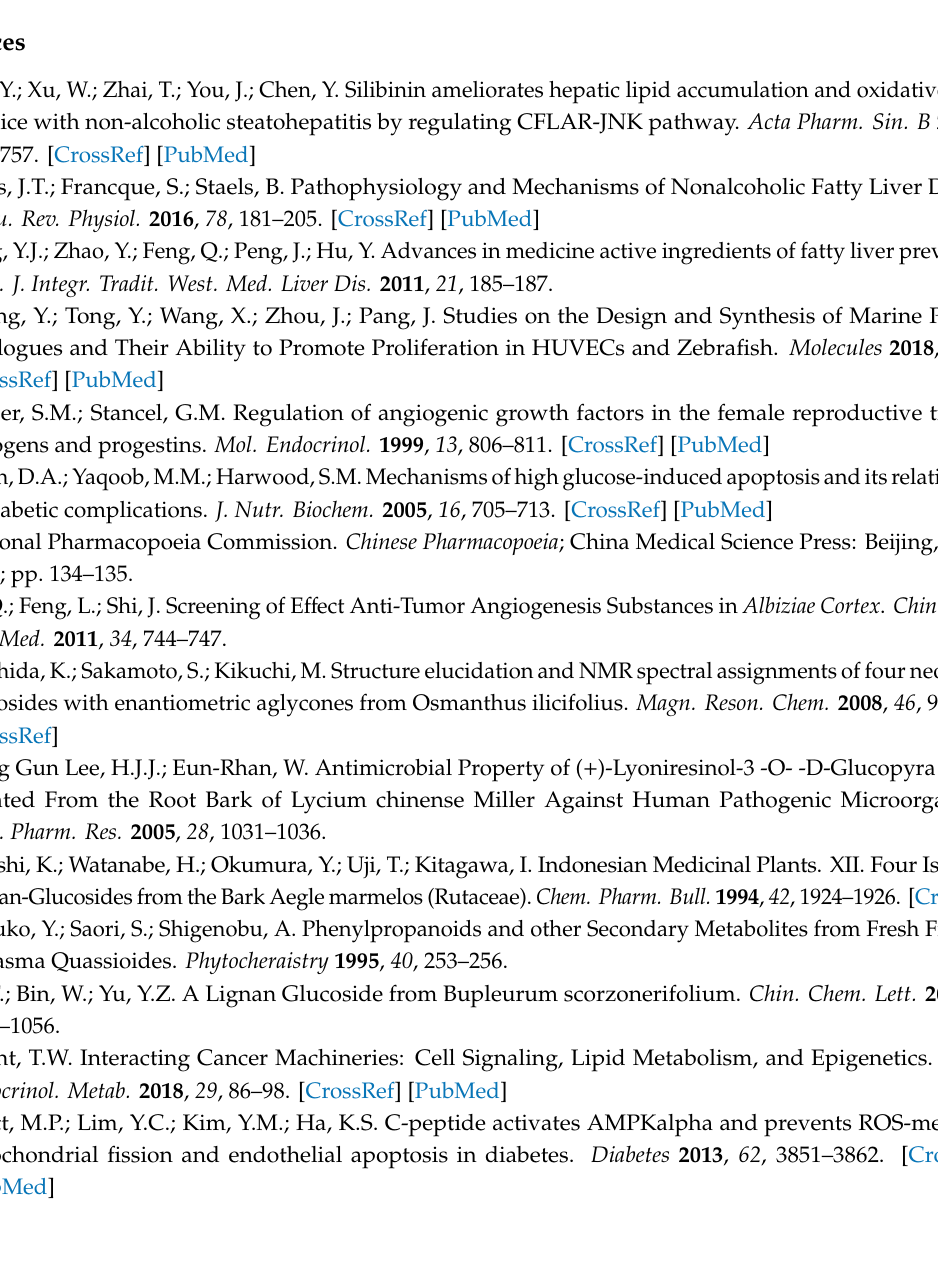
H- 13 C-NMR spectrum of Compound 1. Figure S3: ESI-MS spectrum of Compound 2. Figure S4: 1 H- 13 C-NMR spectrum of Compound 2. Figure S5: ESI-MS spectrum of Compound 3. Figure S6: 1 H- 13 C-NMR spectrum of Compound 3. Figure S7: ESI-MS spectrum of compound 4. Figure S8: 1 H- 13 C-NMR spectrum of compound 4. Figure S9: ESI-MS spectrum of compound 5. Figure S10: 1 H- 13 C-NMR spectrum of compound